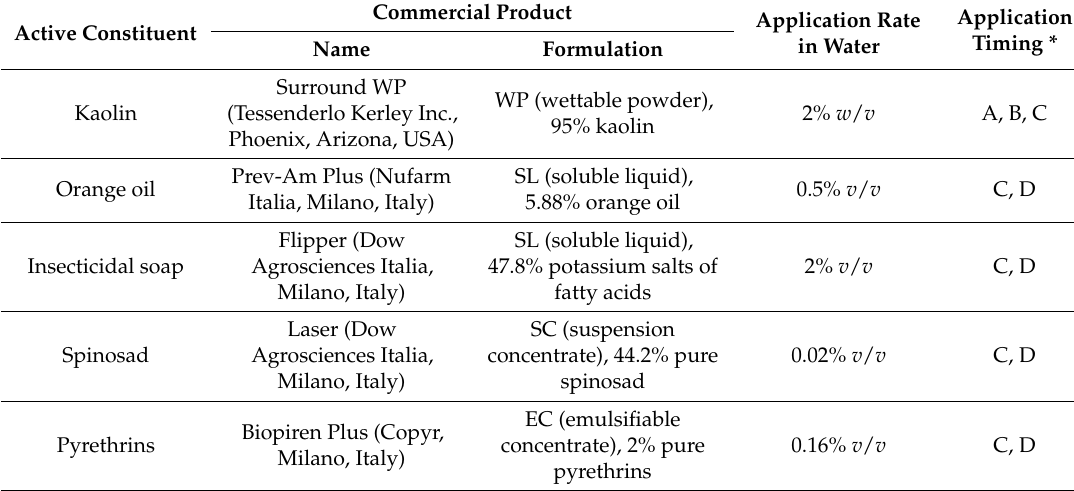
Table 1. Natural products tested in the vineyards against Scaphoideus titanus